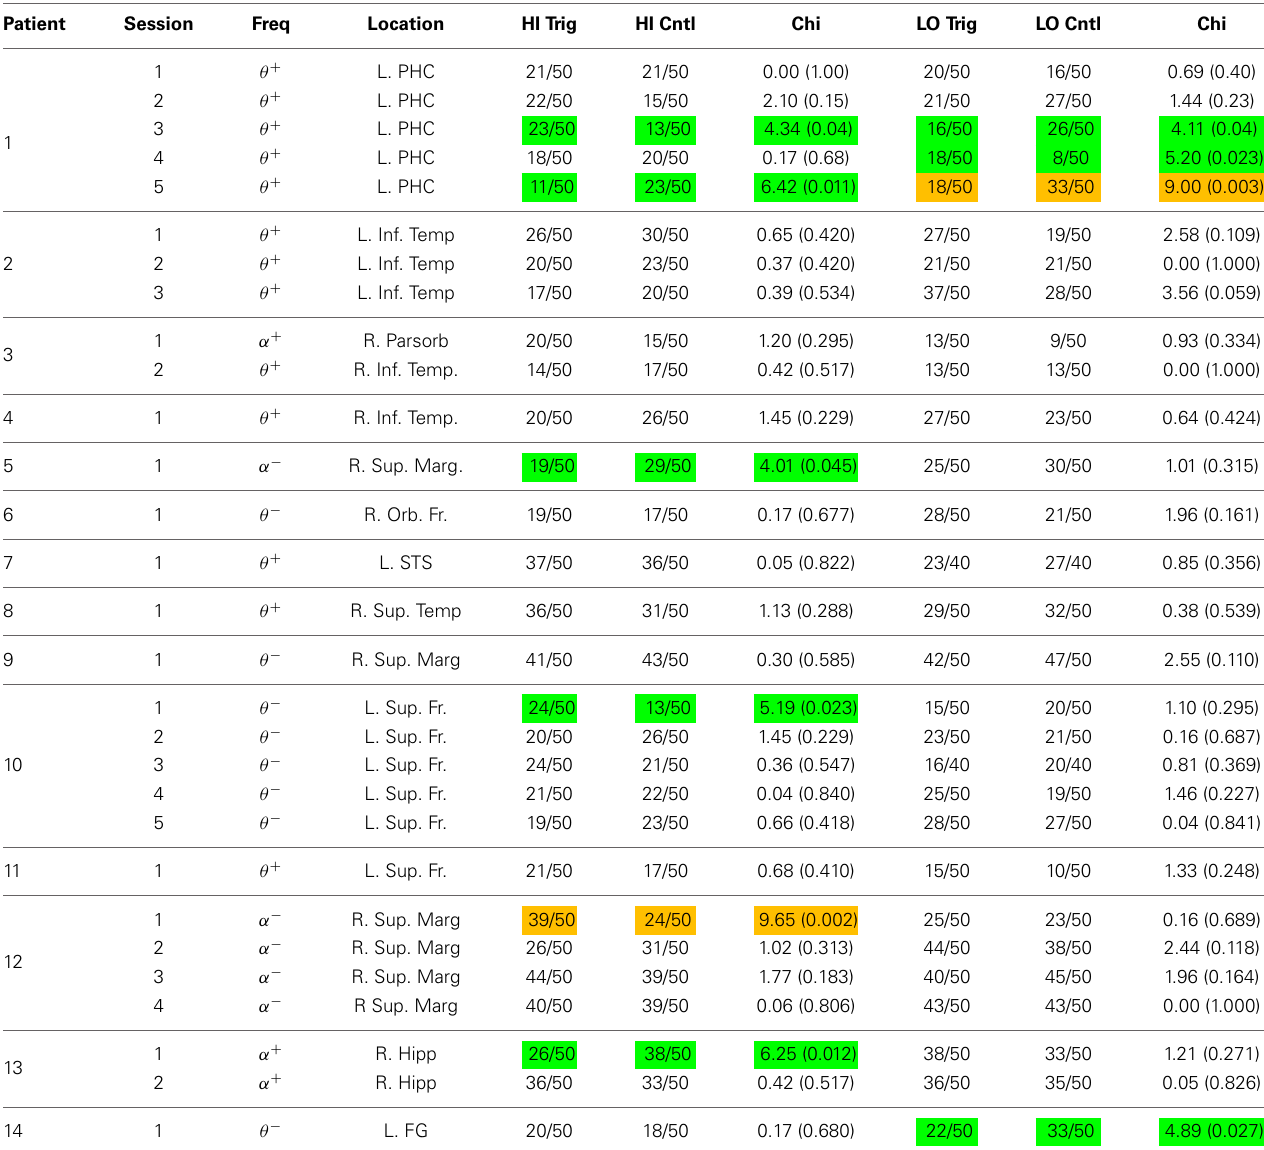
Table 1 | Results of the bciFR